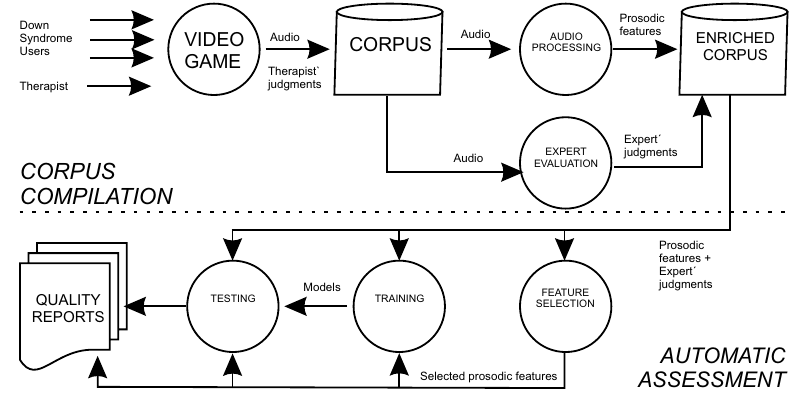
Figure 1. Experimental procedure